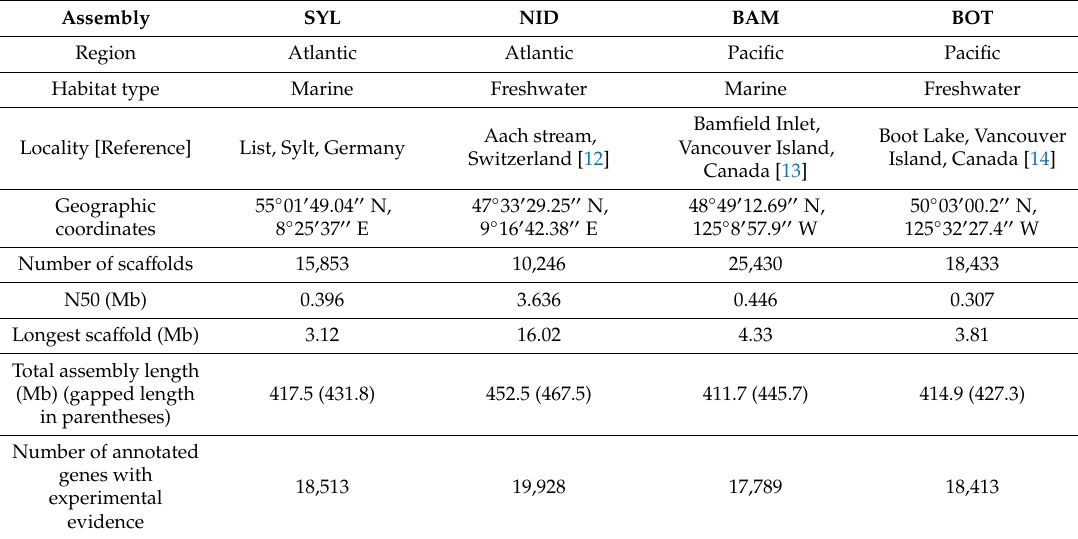
Table 1. Characterization of the four stickleback individuals and their genome